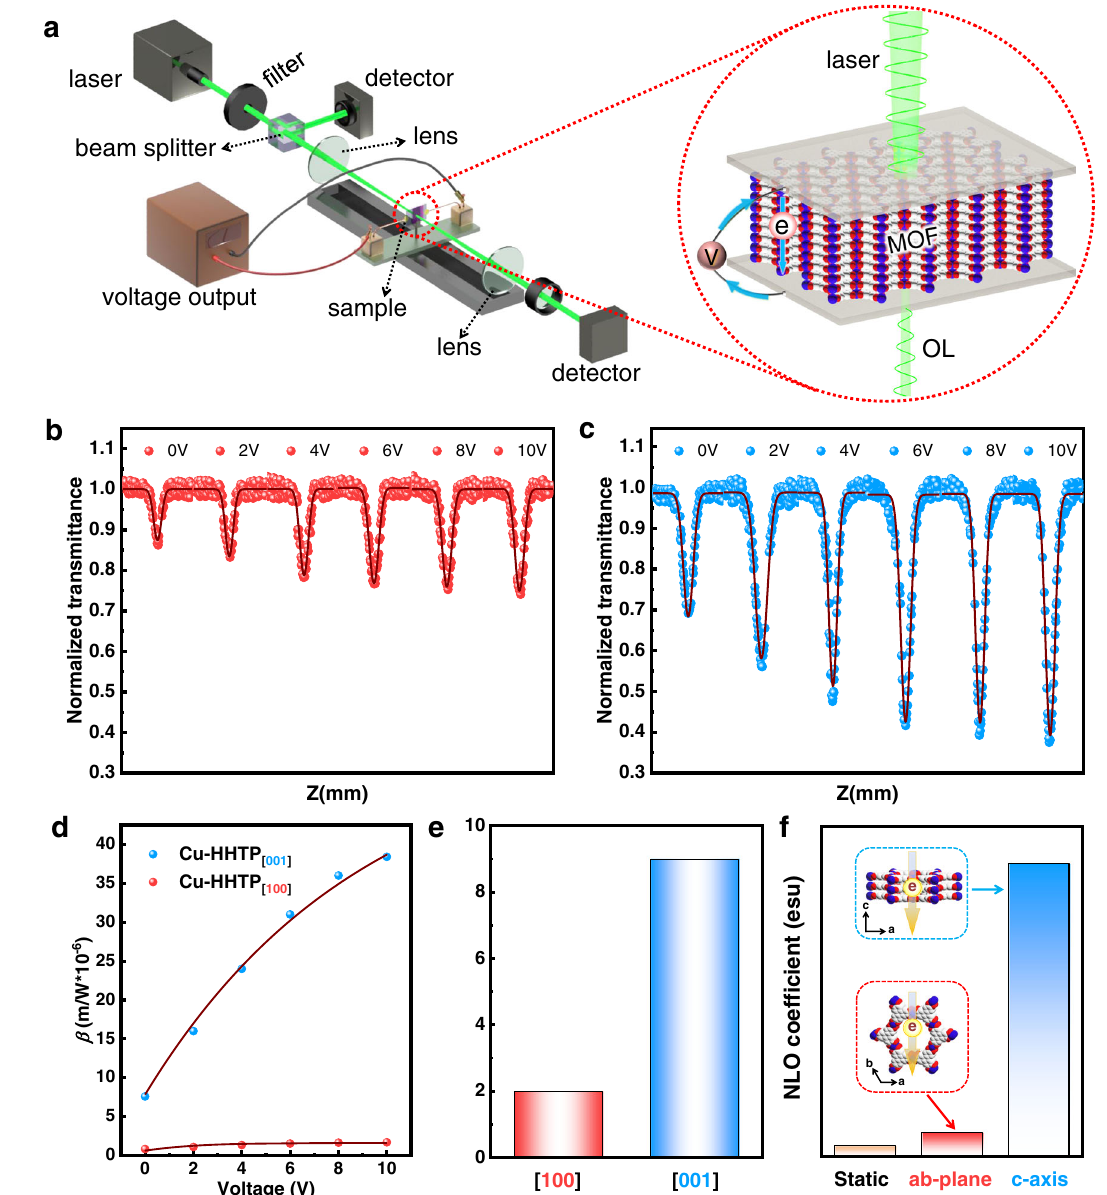
Fig. 5 | Nonlinear optical limiting performance and theoretical calculation of Cu-HHTP fi lmsunderexternalelectric fi eld.a SchematicdiagramofZ-scansetup with external power supply. b , c The open-aperture plots of the fi lms and d the corresponding third-order nonlinear absorption coef fi cient ( β ) and e the R values